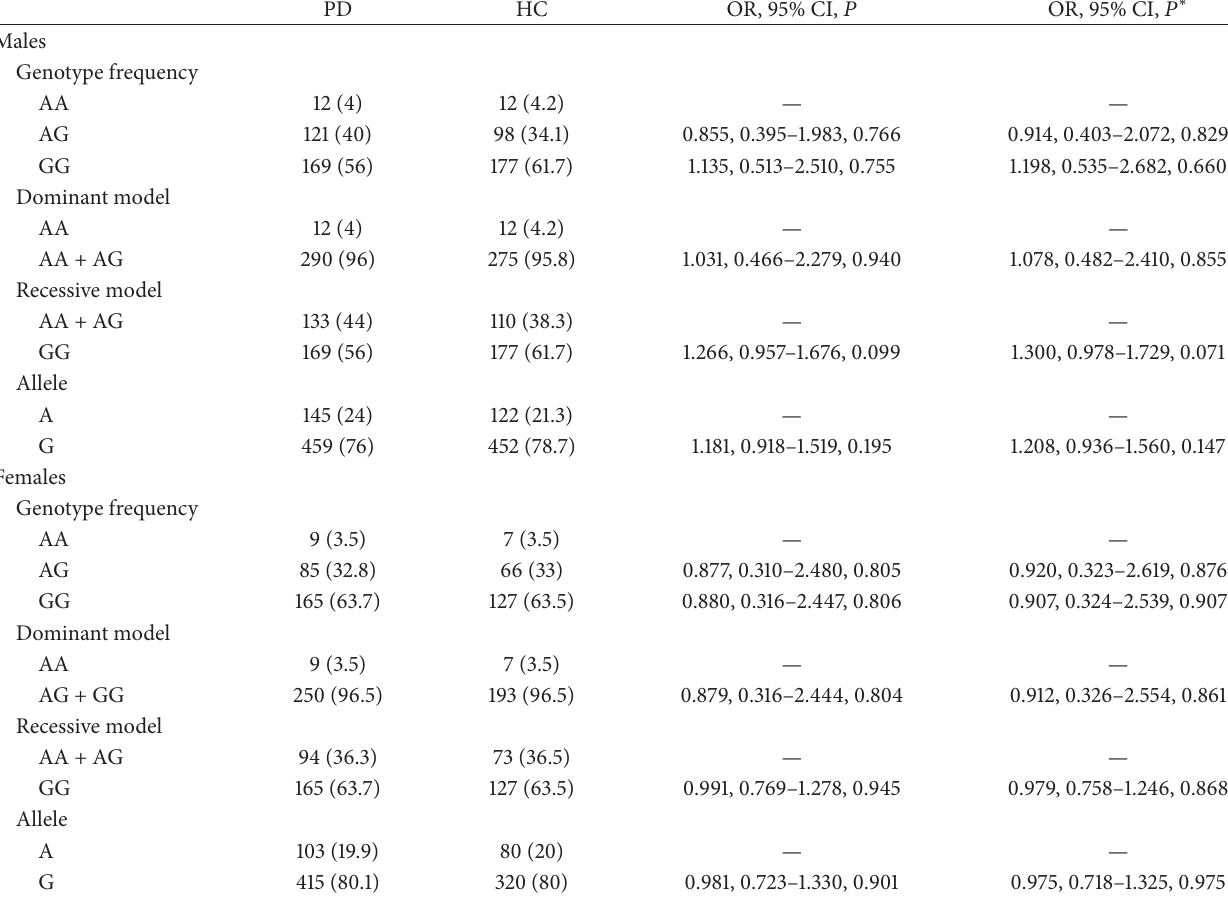
Table 4: Distribution of genotype and alleles at rs363324 among Han Chinese PD patients and controls, stratified by gender.